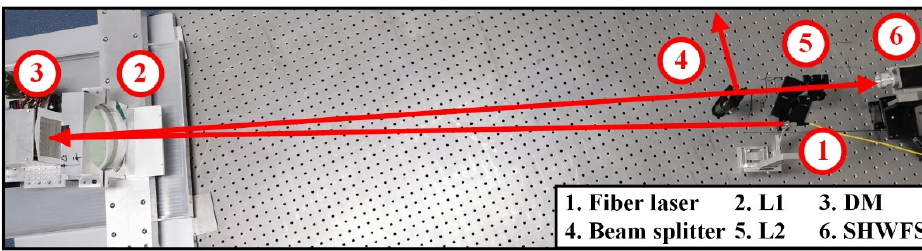
Figure 10. Configuration of the experimental setup.